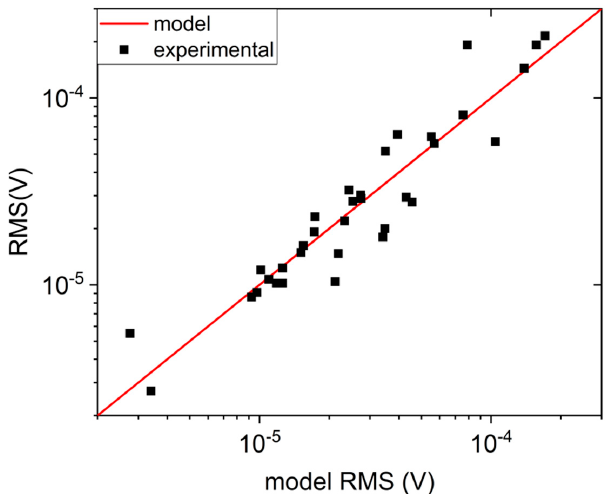
Figure 6. Root mean square value of voltage noise compared for model prediction (red line) and experimental data (black squares). The scale of both axes is logarithmic.